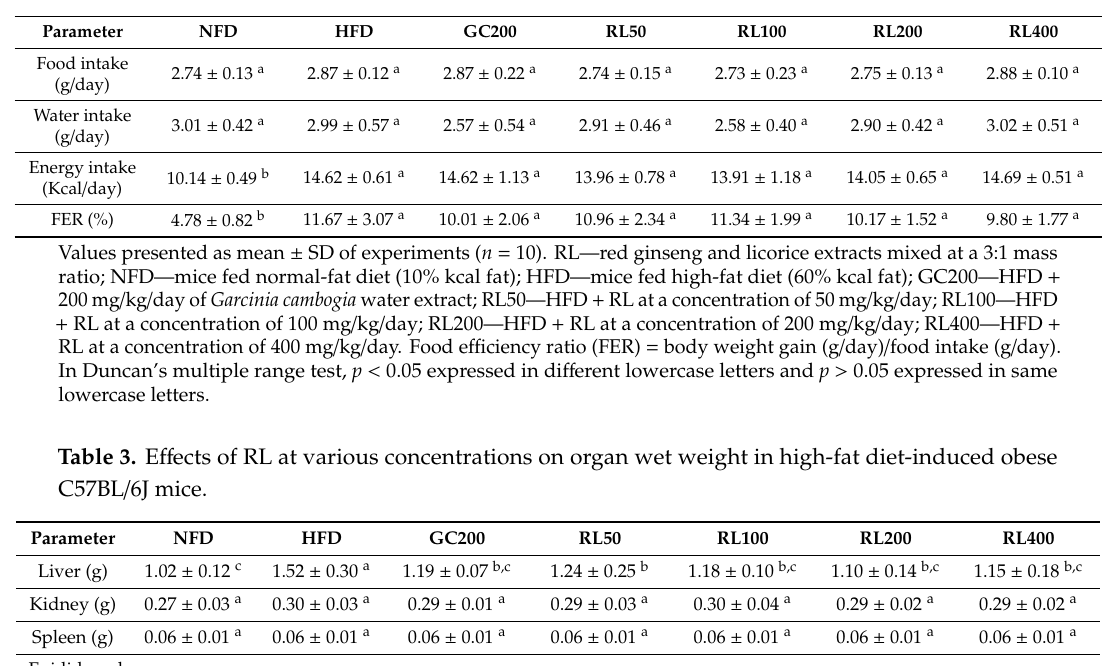
Table 2. E ff ects of RL at various concentrations on food intake, water intake, energy intake and FER in high-fat diet-induced C57BL / 6J mice.